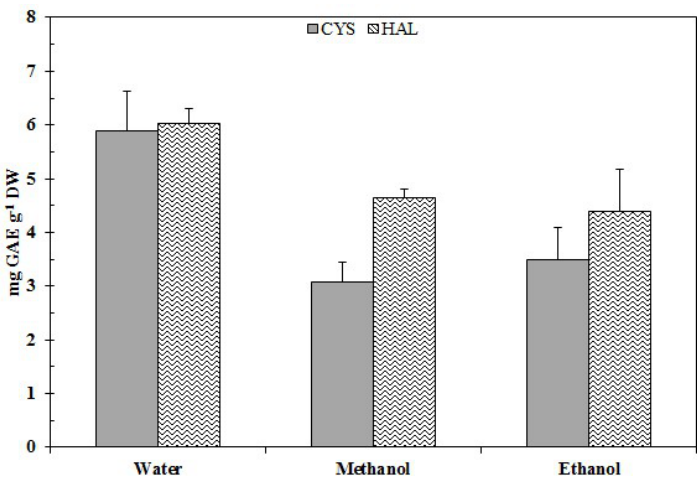
Figure 1. Total polyphenol content in the extracts obtained from CYS and HAL with different solvents.